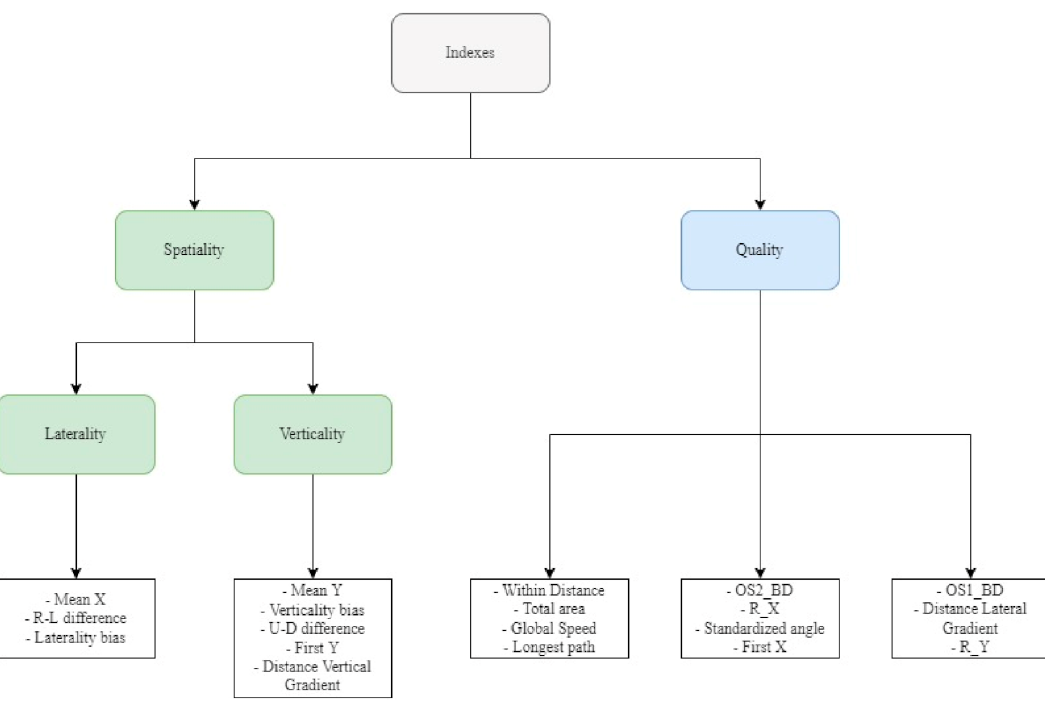
Figure 3. Indexes’